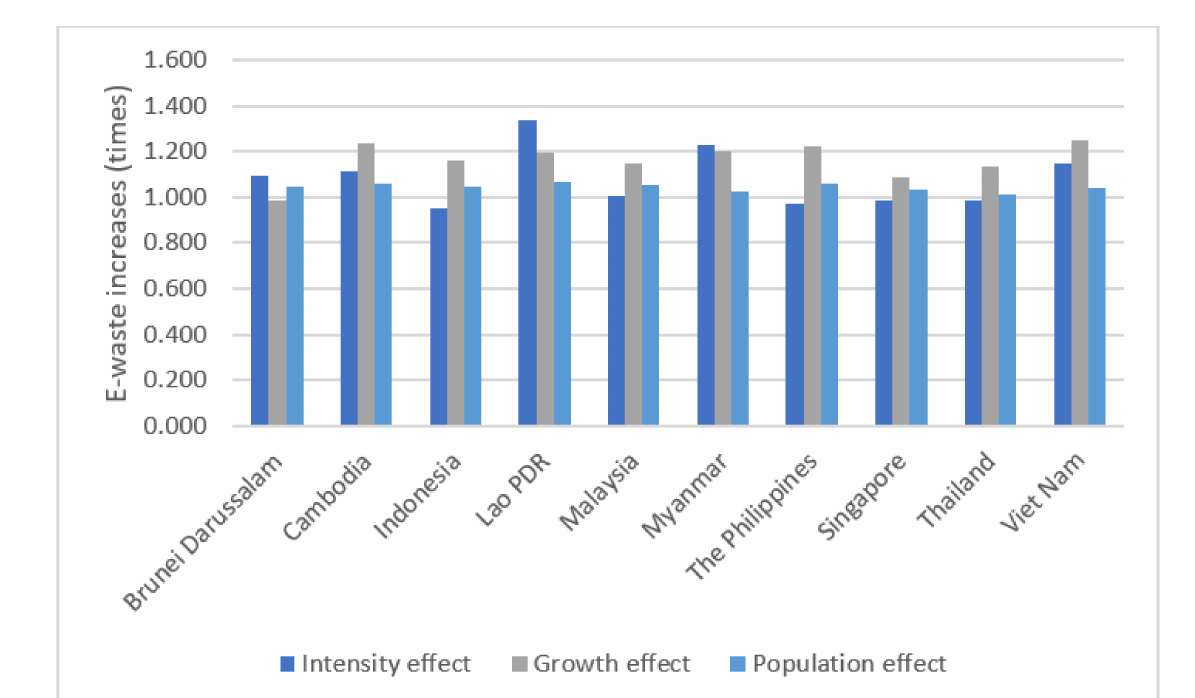
Figure 3. E-waste increases by effect (Multiplicative,